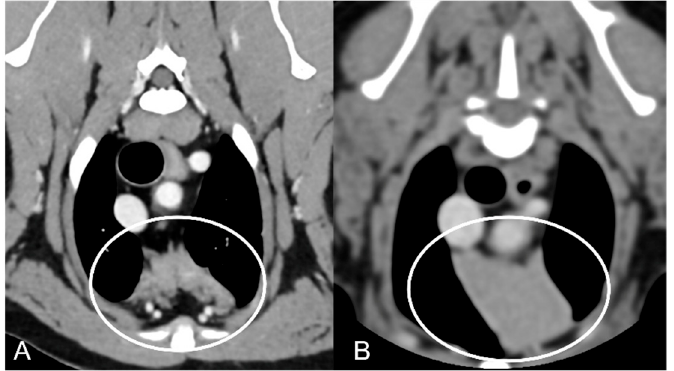
Figure 2. Example of a flattened thymus (circled) in a young dog. Post-contrast dorsal CT reconstruc- tion ( A ) and transverse image ( B ) of the same patient. Note the flattened appearance of the thymus, enlarged in the laterolateral direction (width) and smaller in the dorsoventral direction (thickness).